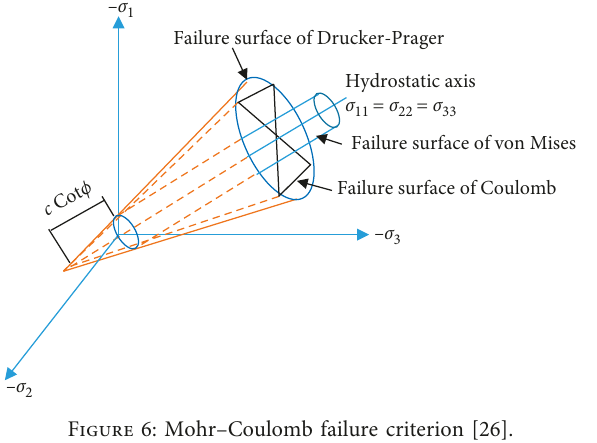
Figure 6: Mohr–Coulomb failure criterion [26].